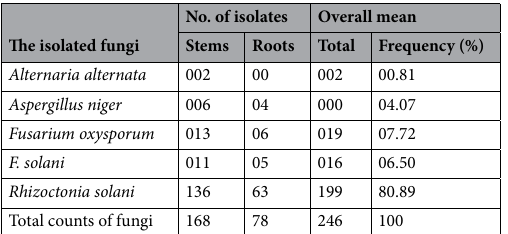
Table 4. The overall mean of frequent fungal species recovers isolated from diseased root rot and basal stem rot of lucky bamboo after beingsurveyed from different locations in the three Egyptian governorates.